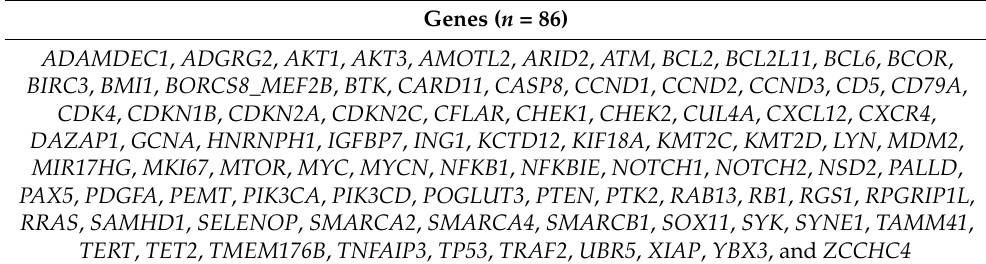
Table 1. Prognostic and pathogenic genes of mantle cell lymphoma.